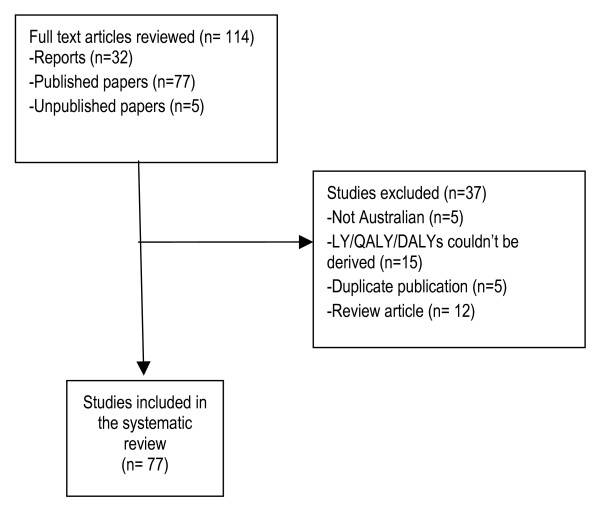
Description of study flow.